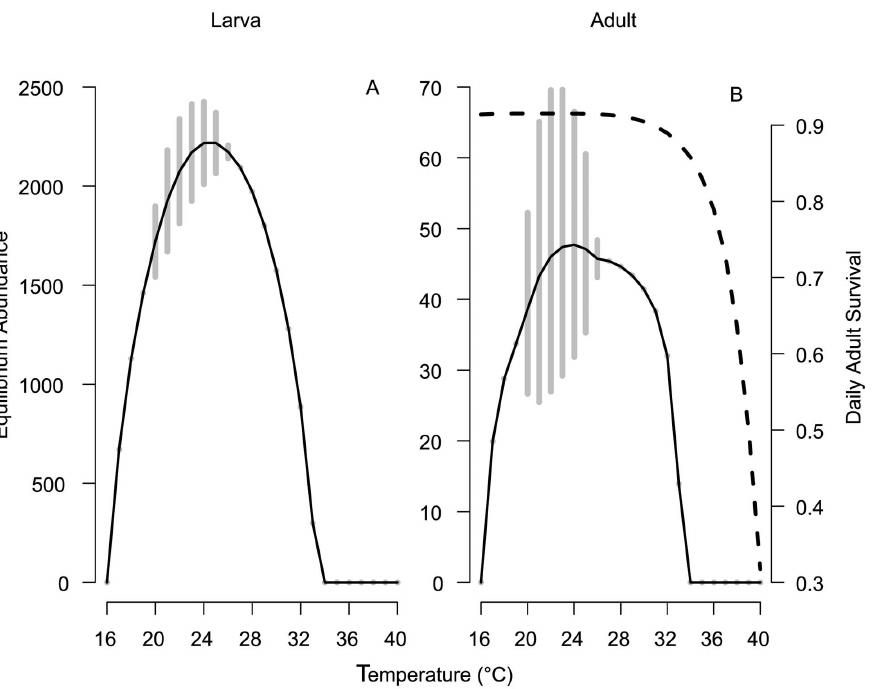
Figure 2. Larval and adult equilibrium abundances. (A) The larval equilibrium abundances across temperatures with exponential density- dependence. (B) The adult equilibrium abundances (solid line, left axis) and daily survival (dashed line, right axis) across temperatures. The gray points and bars in both panels are the stable and cyclic abundances, respectively. The solid line connecting the points is the average abundance across temperature. Notice that the y-axes have different